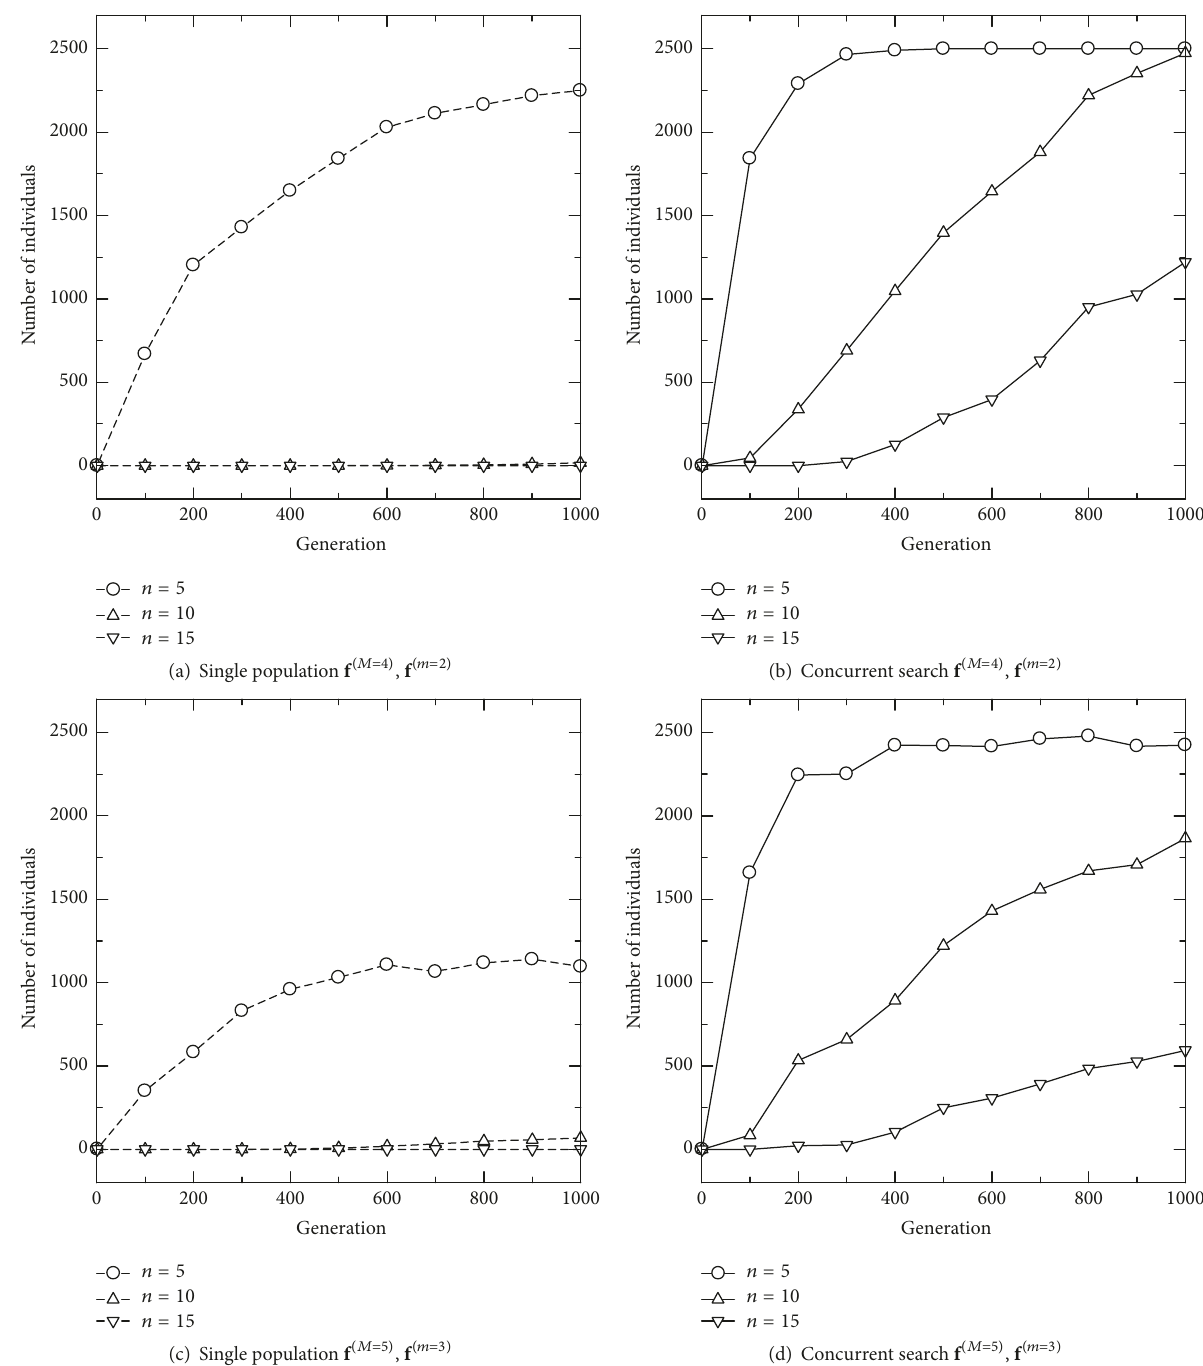
Figure 4: Number of solutions within the desirable area over the generations, that is, solutions located within a distance 𝑑 = 10 of the Pareto optimal solutions in f (𝑚) found by the proposed method. DTLZ3 problem with 𝑚 = 2 and 𝑚 = 3 original objectives and two additional fitness